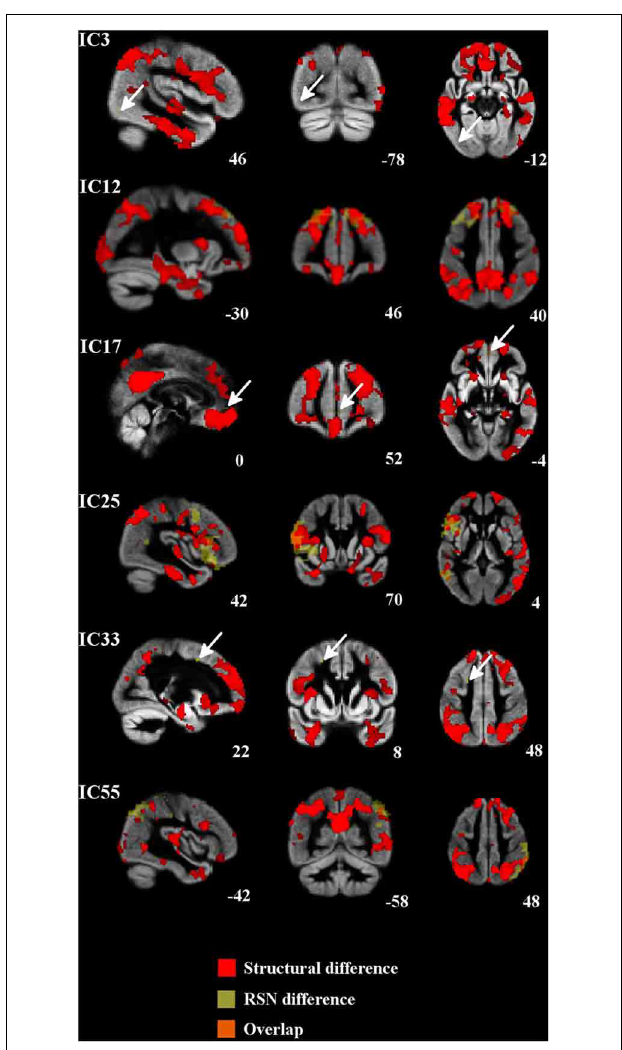
FIGURE 3 | Regional atrophy was detected in several frontal and temporal regions and also in the posterior cingulate cortex, occipital cortex, and occipital poles. Increased connectivity was constantly placed around the atrophied area. Atrophic regions are in red, difference in the RSNs are in yellow (bvFTD > controls) and overlapping areas are in orange color. Arrows in ICs 3, 17, and 33 indicate the difference in the